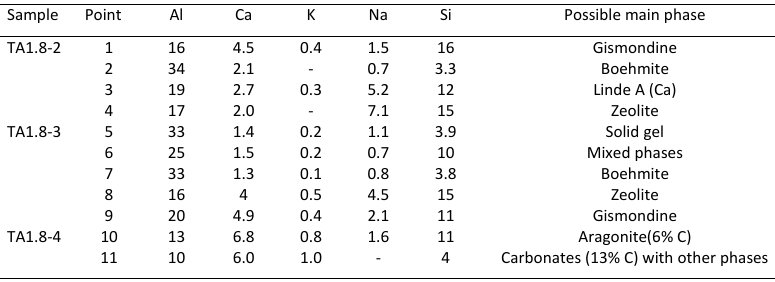
Figure 11. Scanning electron micrographs and point compositions of typical cement microstructures for TSRC specimens with 1.8% by weight of blend TA.